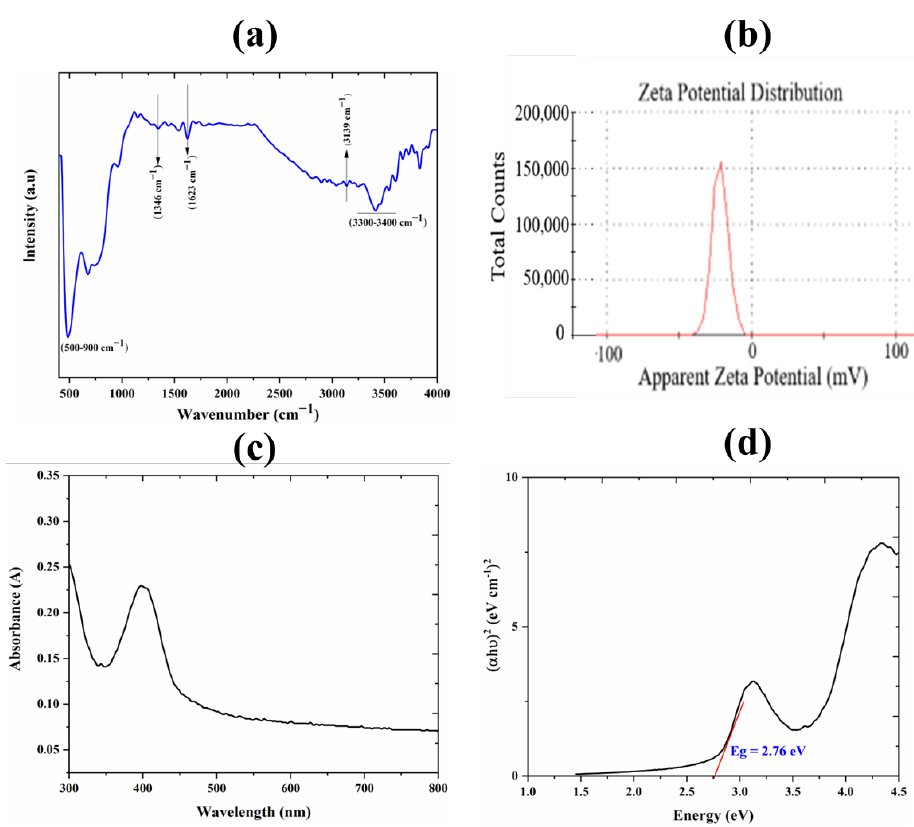
Figure 3. ( a ) FTIR spectra of Cr-N-doped TiO 2 NPs corresponding the characteristic bonds. ( b ) Surface charge determination by zeta potential analysis showing anionic charge ( − 21.7) on surface of NPs. ( c ) UV-Vis absorbance spectra of Cr-N doped TiO 2 NPs showing maximum absorbance in visible range at 400 nm. ( d ) The band gap energies calculated via Tauc Plot showing Eg = 2.76 eV.